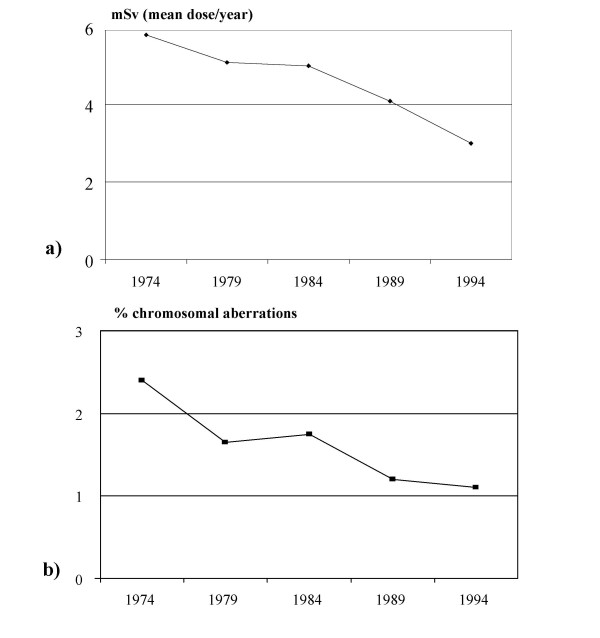
a) Decrease in exposure to ionizing radiation in hospital radiologists over the most recent decades and b) a similar time-related reduction in the frequency of chromosome-type aberrations (redrawn from ref. 58)